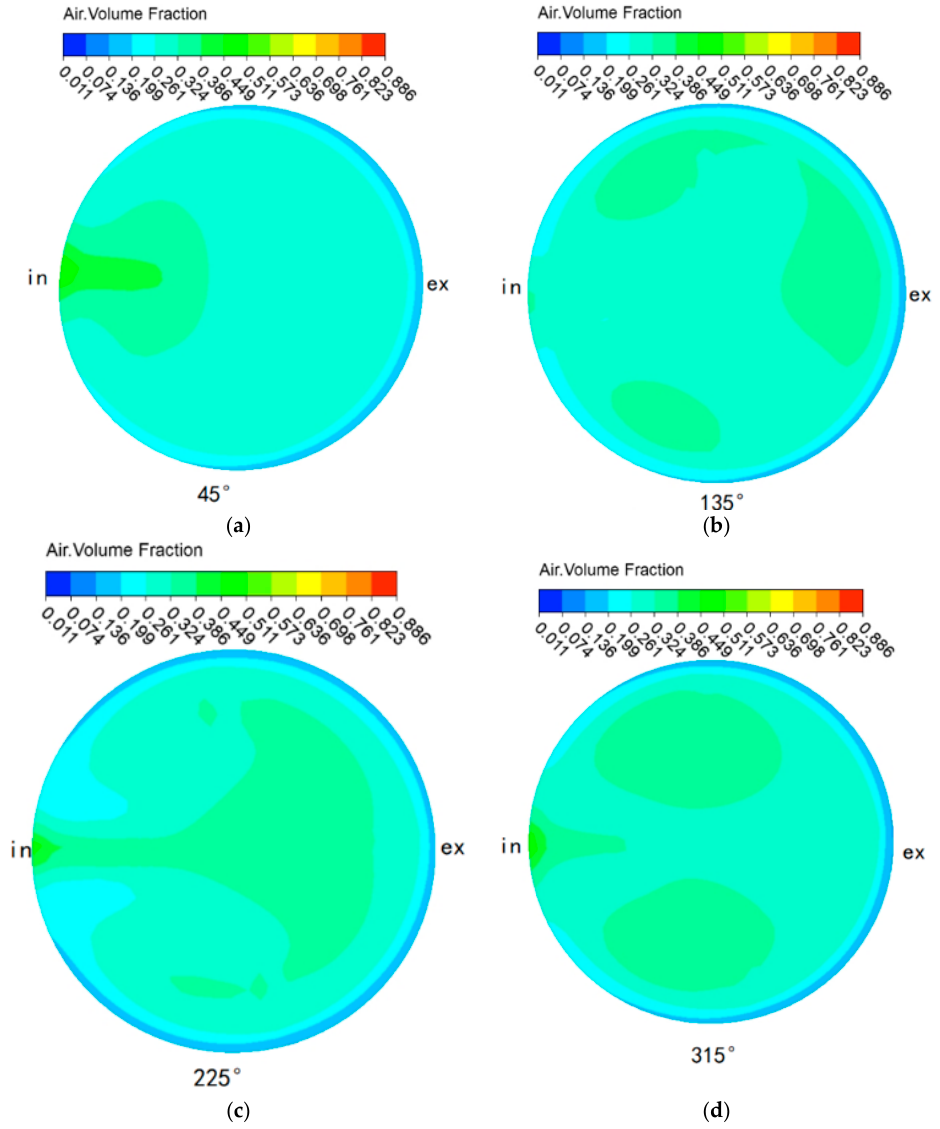
Figure 12. Distribution of gas and liquid phases in cross-sections ( a – d ).